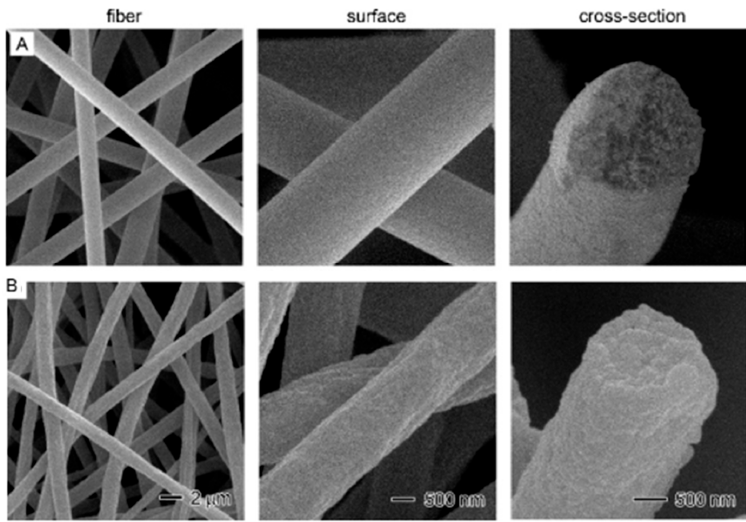
Figure 14. SEM images showing the overview (left column), surface (middle) and cross-section (right) of PS-NFs with different LA/PS ratios: ( A ) pure PS; ( B ) LA0.25PS.